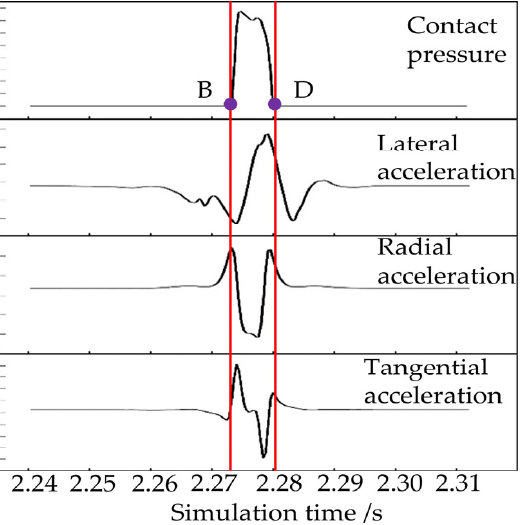
Figure 26. Comparison of acceleration signal and tire contact pressure in a single cycle.